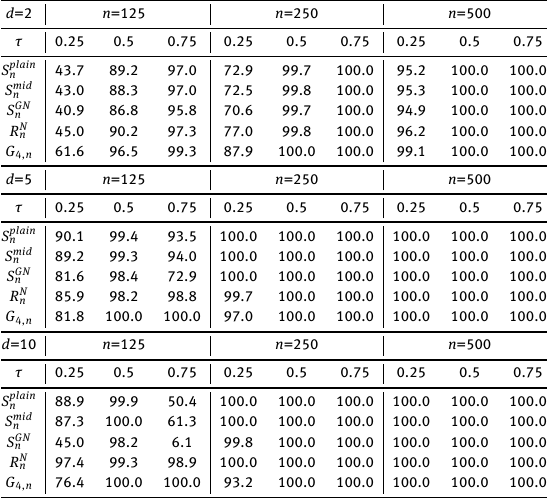
Table 9: Percentages of rejection at a 5% significance level, as estimated from 1000 replicates, for the tests based on S plain n , S mid n , S GN n , R N n and G 4, n under the Clayton